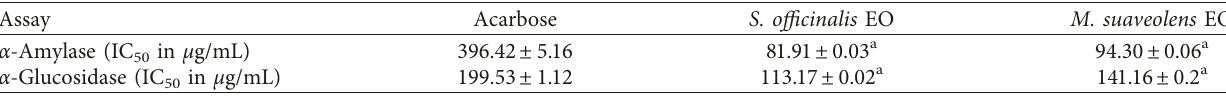
Table 2: In vitro inhibitory effects of Salvia officinalis and Mentha suaveolens essential oils (EOs) on α -amylase and α -glucosidase enzymatic activities. Assay Acarbose α -Amylase (IC 50 in μ g/mL) α -Glucosidase (IC 50 in μ g/mL)